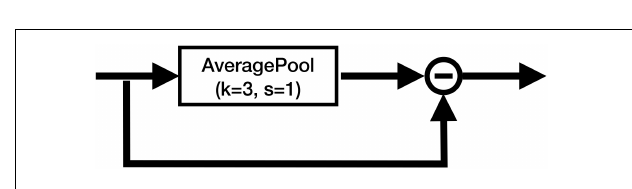
FIGURE 4 | Structure of the CA module. “ − ” denotes the element-wise subtraction.